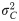
A: Generative model involved during choice between two options, one associated with high reward (RH = 10) and the other with low reward (RL = 6) when a third option (associated with reward R3) is also available [6]. B: Proportion of choices of the better over choices of the worse option predicted by BCV (P[RH|RH,RL,R3]/P[RL|RH,RL,R3]), as a function of the third option reward R3 and prior expectation μC (100000 trials are simulated for each condition; σC2 = 1 for simulations). Here, the reward uncertainty σR2 was set to 0.1; C: The same simulation is reported except that the reward uncertainty σR2 was set to one. D: The same simulation is reported except that the reward uncertainty σR2 was set to ten.